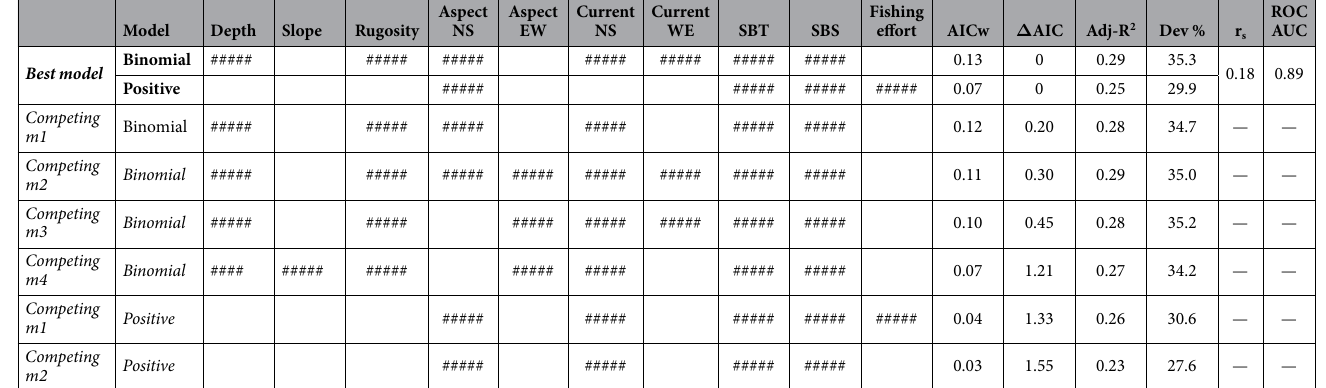
Table 4. Best supported and competing models (using binomial and positive models) for Isidella elongata . Variables included in model are indicated with the symbol #. Predictors include depth, slope, rugosity, aspectNS, aspectEW, CurrentNS, CurrentWE, sea bottom temperature (SBT), sea bottom salinity (SBS) and fishing effort. Δ AIC: delta AIC (difference in AIC between the best model and current model); AICw: Akaike’s Information Criteria (corrected) weights, values range from 0 to 1, and high values indicate strong support for a given predictor. Models were evaluated by R 2 -adjusted coefficient and deviance (Dev): percentage of deviance explained. Only for the binomial model the Receiver Operating Characteristic (ROC) and Area Under the Curve (AUC) were calculated. Significance value of the Spearman’s correlation coefficient (rs) (corrected for spatial autocorrelation) for the delta model is given as *** p value < 0.001, ** p value < 0.01, * p value < 0.05.